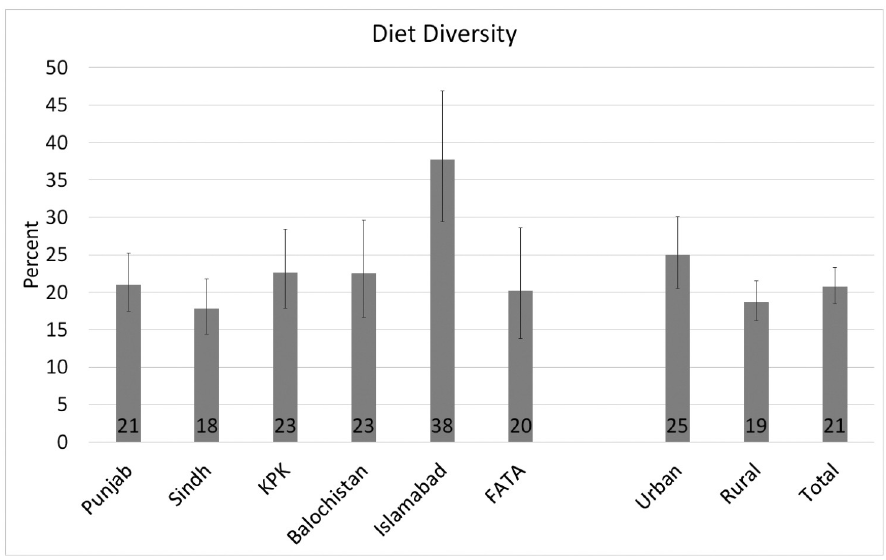
Fig 1. Prevalence of minimum diet diversity for children aged 6–23 months across regions and urban/rural areas in Pakistan (2017–18): 95% confidence intervals are represented by error bars. Source: Author using DHS (2017– 18)